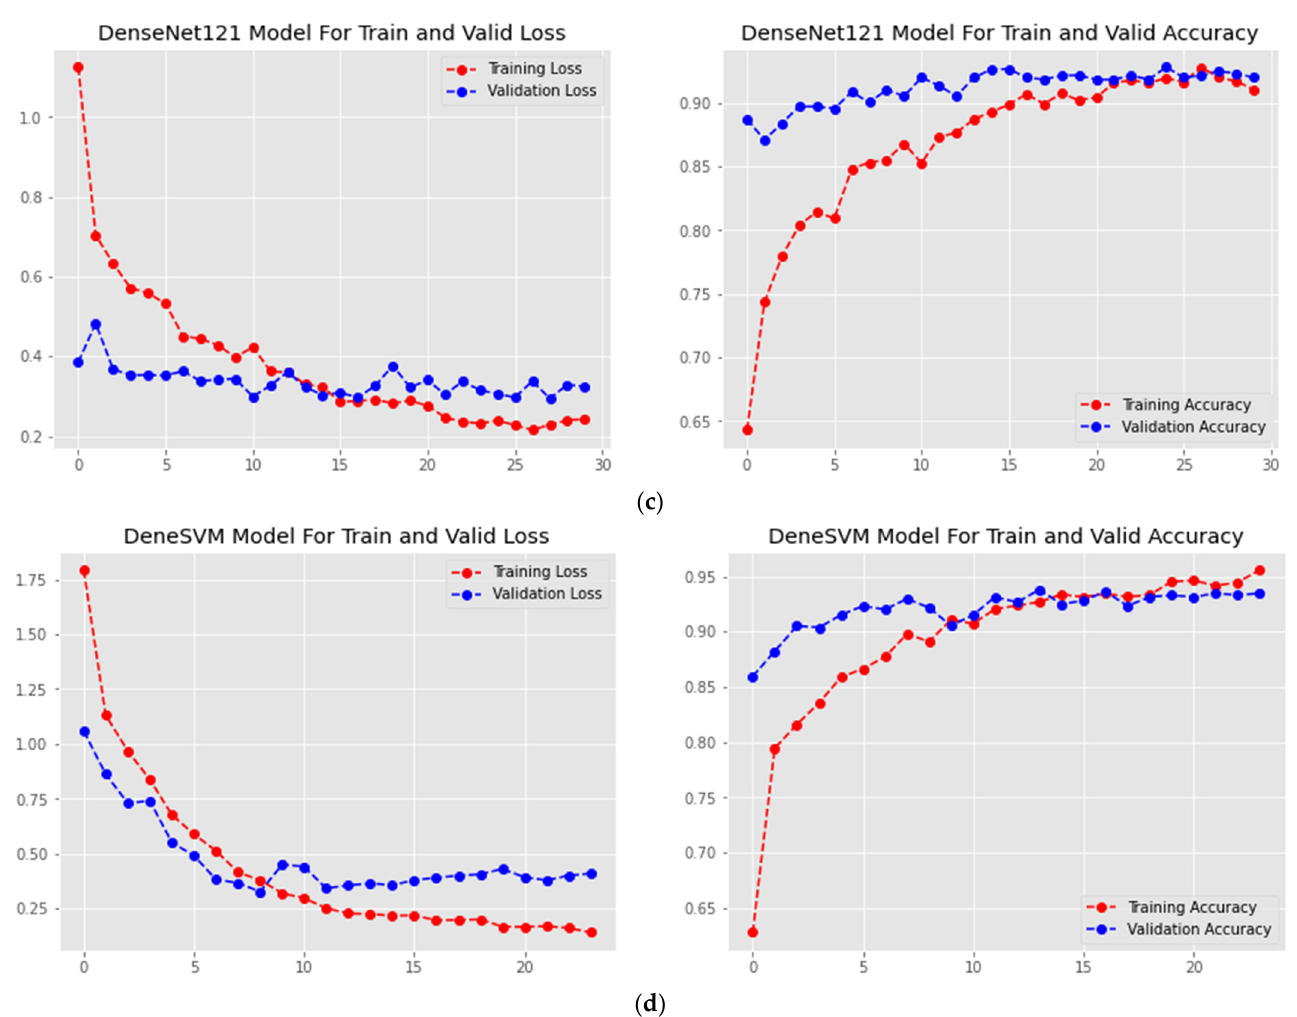
Figure 3. Accuracy and loss graphs of DTL models: ( a ) InceptionV3; ( b ) ResNet50; ( c ) DenseNet121; and ( d ) Proposed Inception-SVM.